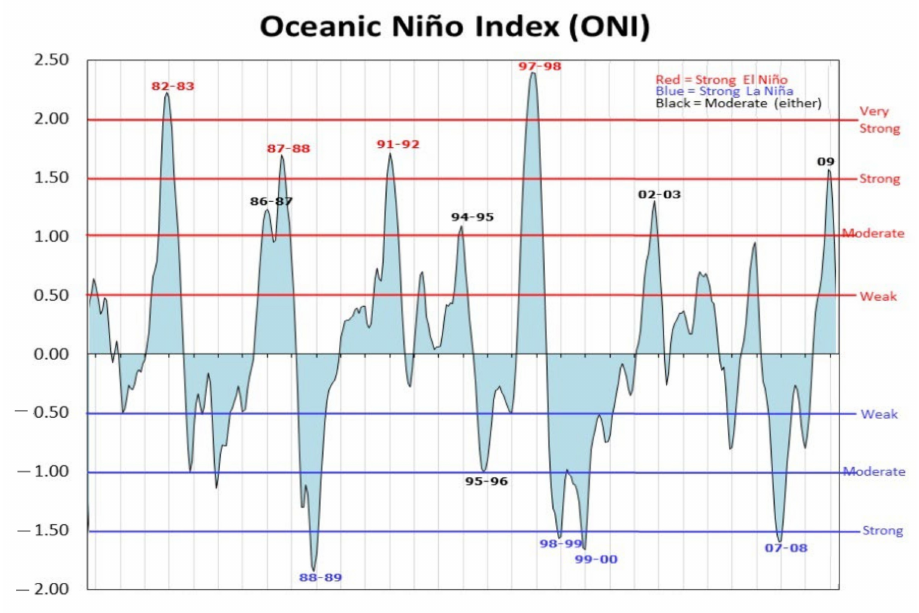
Figure 14. Oceanic Nino Index (ONI) for the period 1980–2010 (31 years). Adapted from